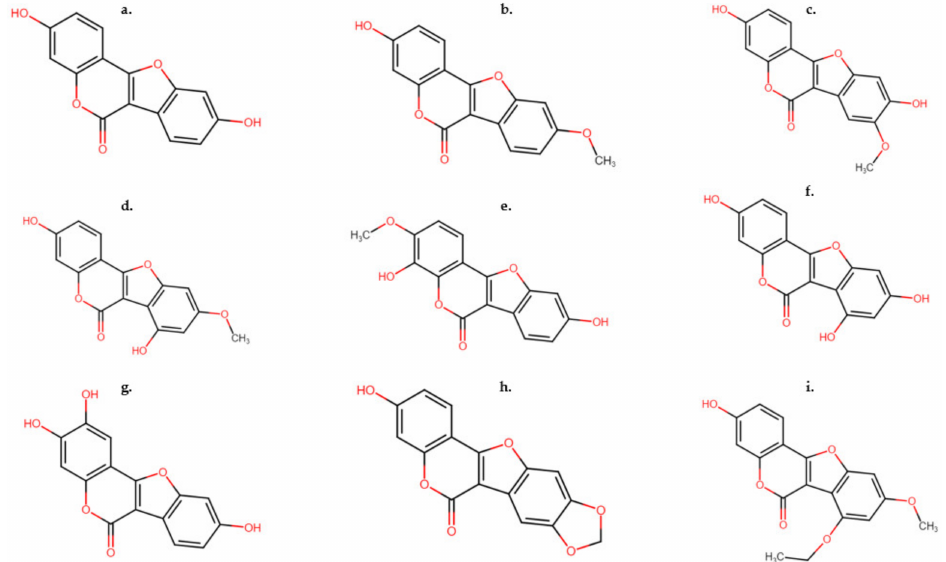
Figure 2. Structures of common coumestans found in legume species. ( a ) Coumestrol, ( b ) 4 (cid:48) methoxycoumestrol, ( c ) 3 (cid:48) methoxycoumestrol, ( d ) trifoliol, ( e ) sativol, ( f ) repensol, ( g ) lucernol, ( h ) medicagol and ( i ) 11,12-